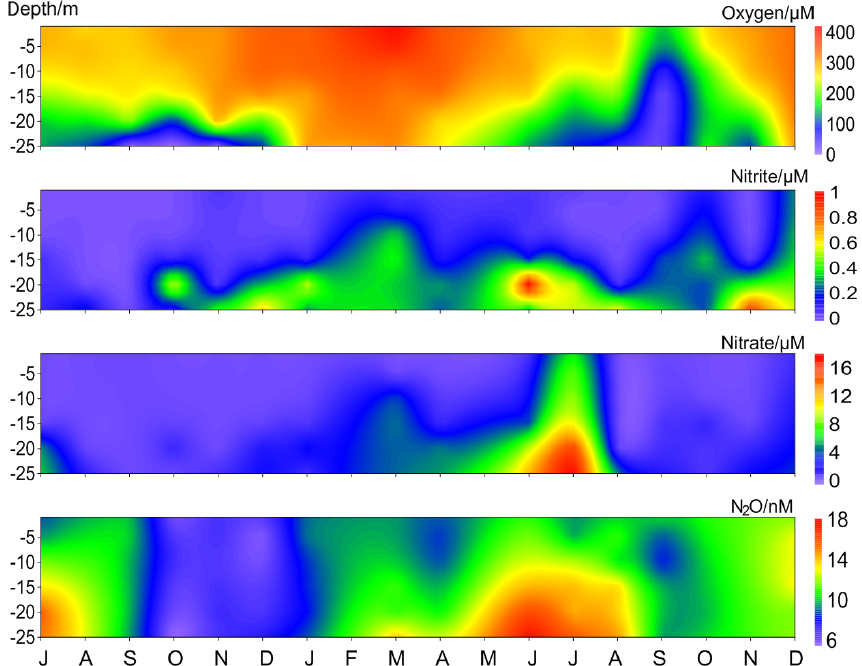
Figure 5. Vertical distribution of dissolved O 2 , NO − Please note that the high N 2 O concentrations in November 2017 were removed for better